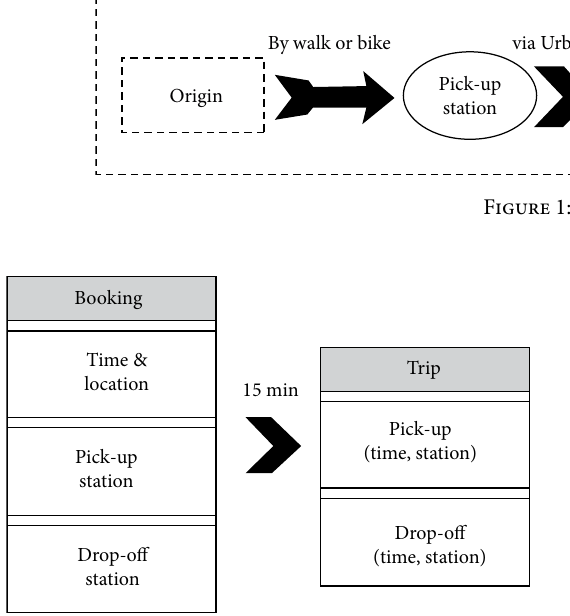
Figure 2: A record of a successful car sharing